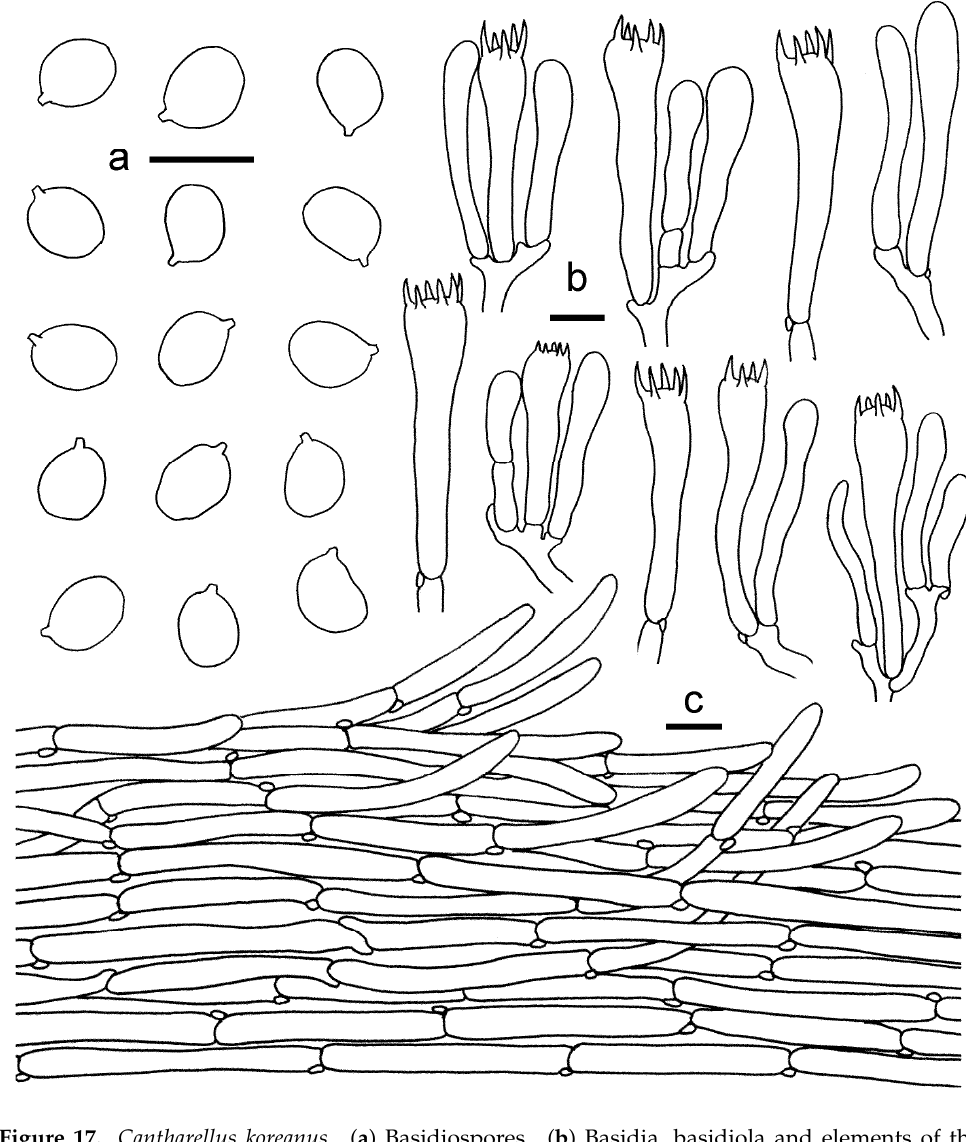
Figure 17. Cantharellus koreanus . ( a ) Basidiospores. ( b ) Basidia, basidiola and elements of the subhy- menium. ( c ) Pileipellis. Bars: ( a , b ) = 10 μ m; ( c ) = 20 μ m. Basidiomata small-sized. Pileus 15–40 mm broad, convex at first, then gradually ap- planate with slightly an umbilicate centre; margin involute at first, undulate; surface dry, glabrous or finely tomentose-fibrillose at centre, mostly pale yellow to light yellow (1A3– 4A3,1A4–4A4), olive brown to light brown (4D4–5D4) at centre, with obscurely sulcate at margin. Hymenophore with lamellate ridges; ridges broadly adnate to subdecurrent, with a clearly delimitation from the stipe surface, well-developed, bifurcate and with intercon- nected low veins, up to 1 mm high, yellowish white (2A2–4A2), unchanging when bruised. Stipe10–40 mm long, 2–5 mm thick, subcylindrical to cylindrical, slightly enlarged down- ward, but sometimes tapering towards base, glabrous or with faintly scaly, hollow, con-